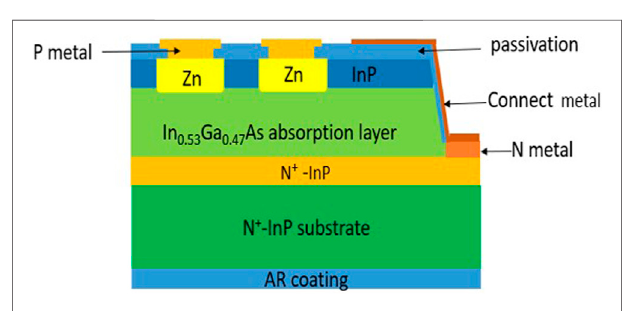
FIGURE 2 | Cross-section of